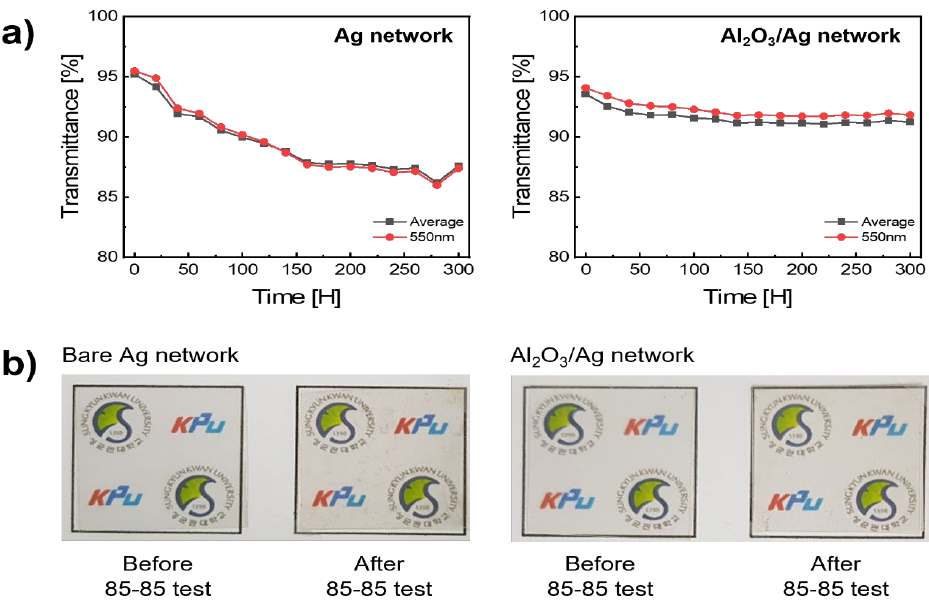
Figure 5. ( a ) Optical transmittance changes in the bare Ag and Al 2 O 3 /Ag network electrodes as a function of time during the 85 ◦ C–85% RH test. ( b ) Photograph of the bare Ag and Al 2 O 3 /Ag network electrodes before and after 85 ◦ C–85% RH